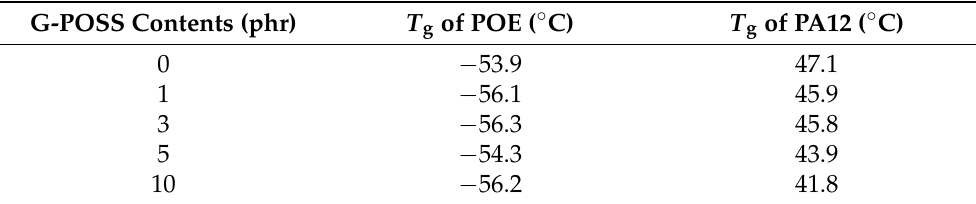
Table 2. Glass transition temperature of samples.